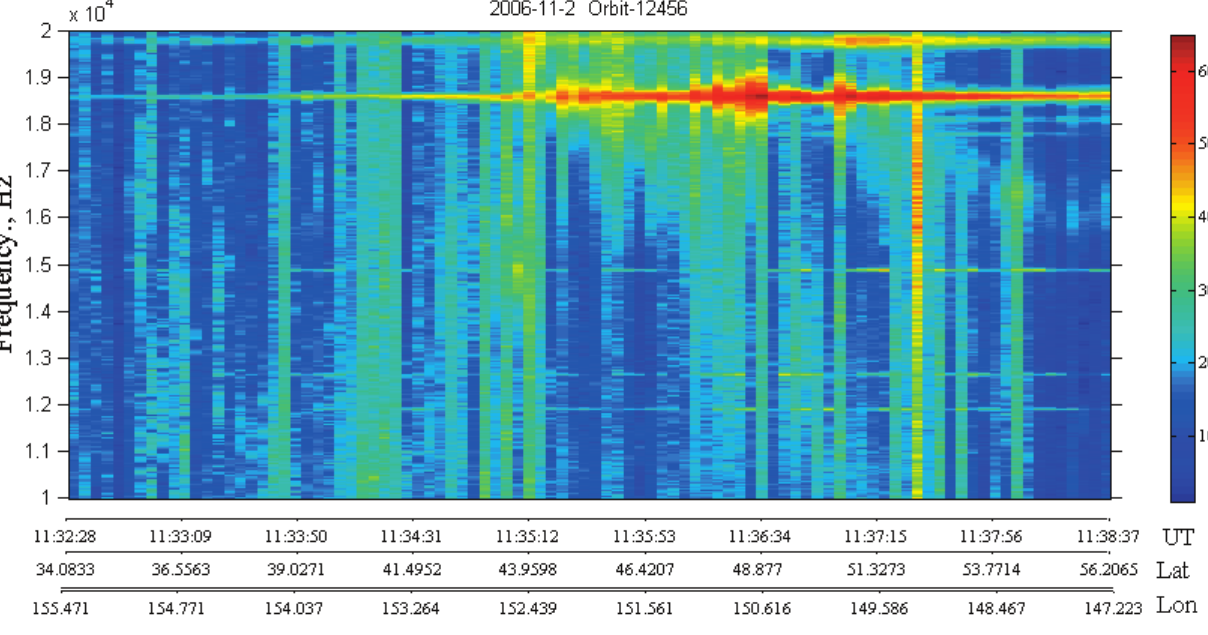
Figure 4. Dynamic spectra of the VLF signal variations for parts of the orbits passing above the earthquake area, for the frequency band 10 kHz to 20 kHz. The disturbed day of November 2, 2006, is